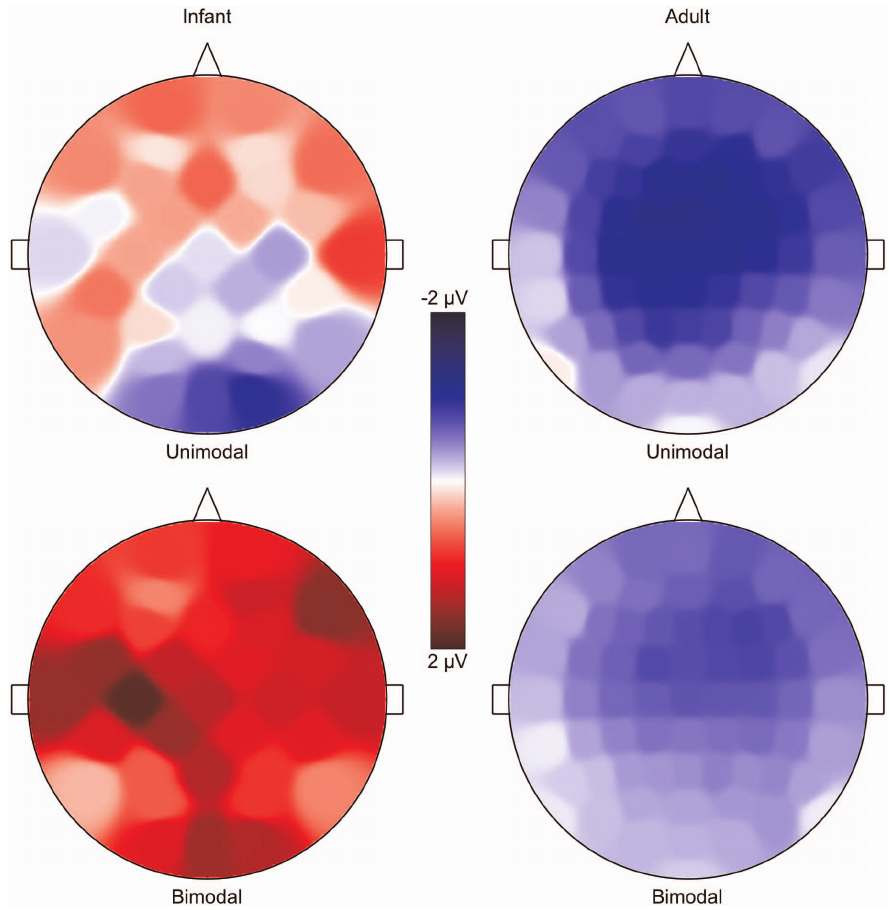
Figure 3. MMR scalp distributions. Unimodally (top) and bimodally (bottom) trained infants in [4] (left; 32 electrodes) and adults in the current study (right; 64 electrodes). Voltages time-averaged between 167 and 217 ms after stimulus onset for adults, between 100 and 500 ms for infants. Blue is negative, red positive, white zero.